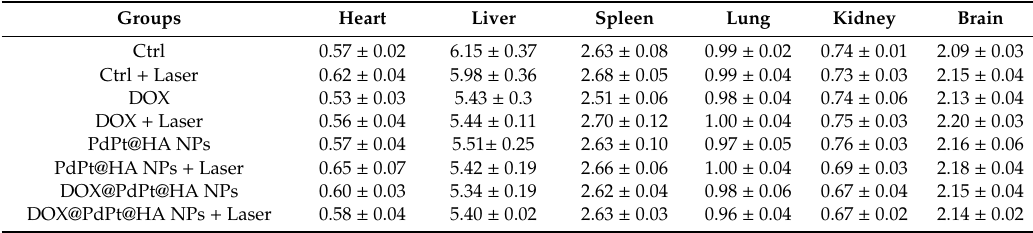
Table 1. E ff ects of di ff erent treatments on the organ coe ffi cient of mice.